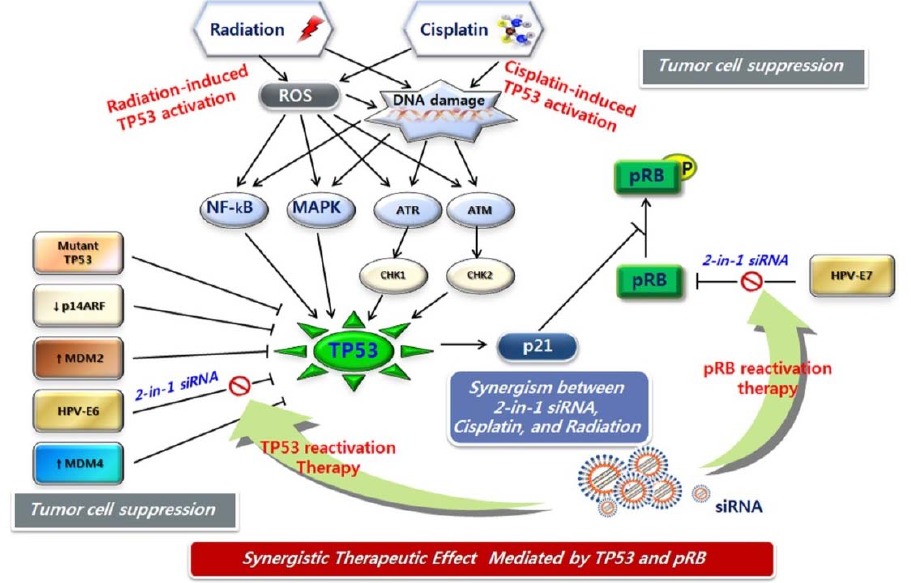
Figure 4. Dual activation of TP53 and pRB in combination therapy with CCRT and HPV E6/E7 siRNA. Cisplatin and radiation therapies induce TP53 activation by DNA damage signal transduction. HPV E6/E7 siRNA treatment results in TP53 and pRb reactivation. Combination therapy with CCRT and HPV E6/E7 siRNA may fully activate functional TP53 and pRb through different transduction mechanisms, leading to strong cellular